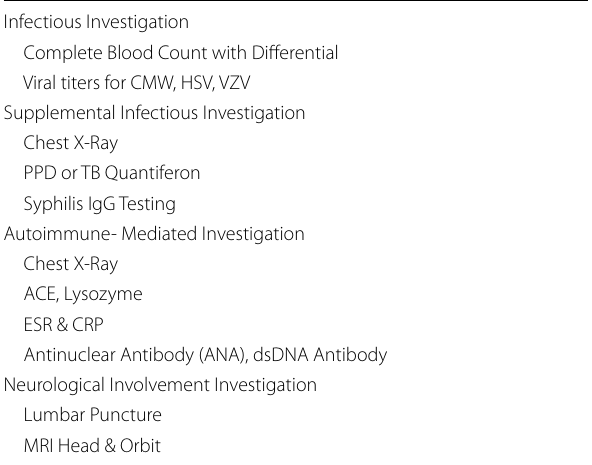
Table 1 Introductory imaging and laboratory studies for frosted branch angiitis